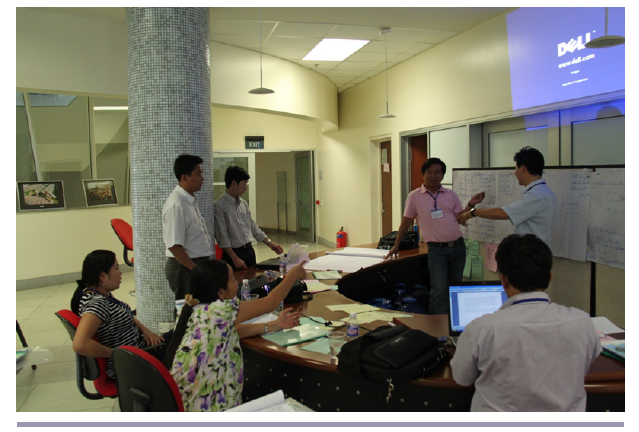
Fig. 4 . Combining verbal and written narration: Vietnam Group